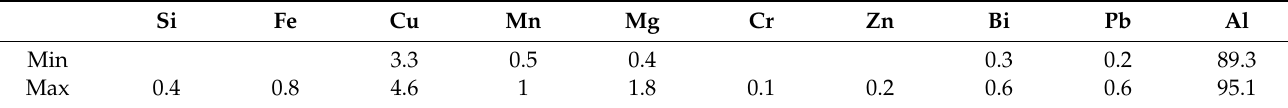
Table 1. Chemical composition of the tested aluminium alloy (% by volume) [26].